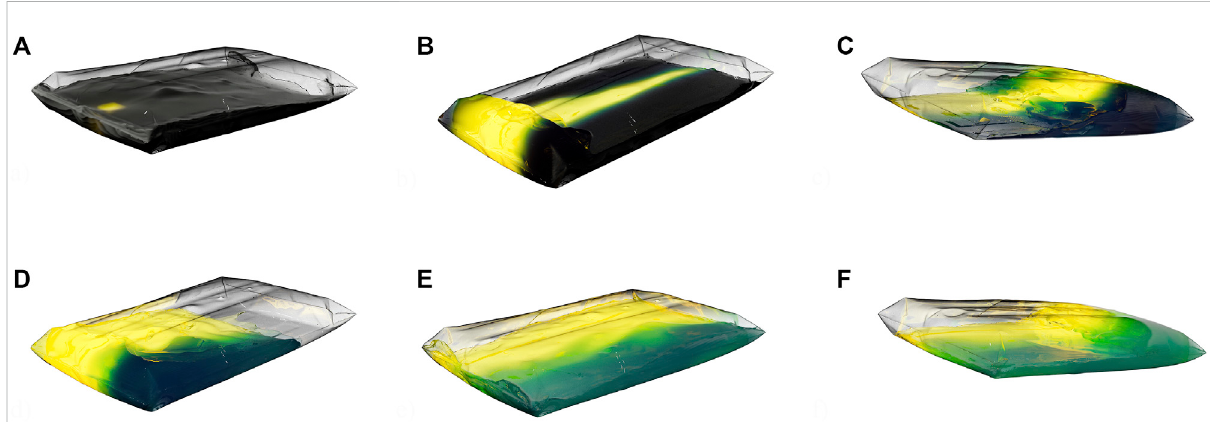
FIGURE 11 Thevolume-renderedCGIshow theconcentrationchangeofthetracerovertime.Thesimulationat11.5L,25 rpmand16.48 ° isshown. (A) The tracer (yellow) was added at t = 0 s (after the start-up phase and 10 complete revolutions). Images (B) ( t = 1.5 s) and (C) ( t = 3 s) show rapid mixing in therocking direction. Images (D – F) ( t =4.5s, t =6s, t = 7.5 s) show theslower mixing inthe orthogonal direction. The Viridis color map wasused for representation.